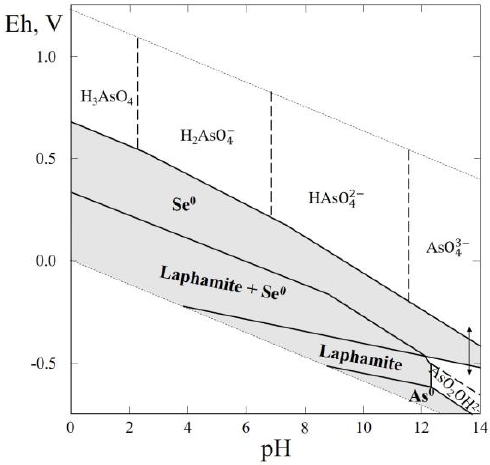
Figure 12. Eh-pH diagram of the OHSeAs (As-Se-H 2 O) system at 25 °C and the activities of the components: a Σ Se = 10 − 4 , a Σ As = 10 − 3 . The dotted lines are the boundaries between fields of H 3 AsO 40 , H 2 AsO 4 − , HAsO 4 2− and AsO 4 3− .